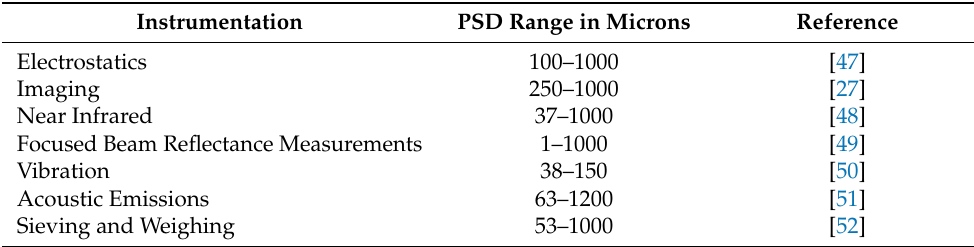
Table 1. PSD monitoring sensors and their